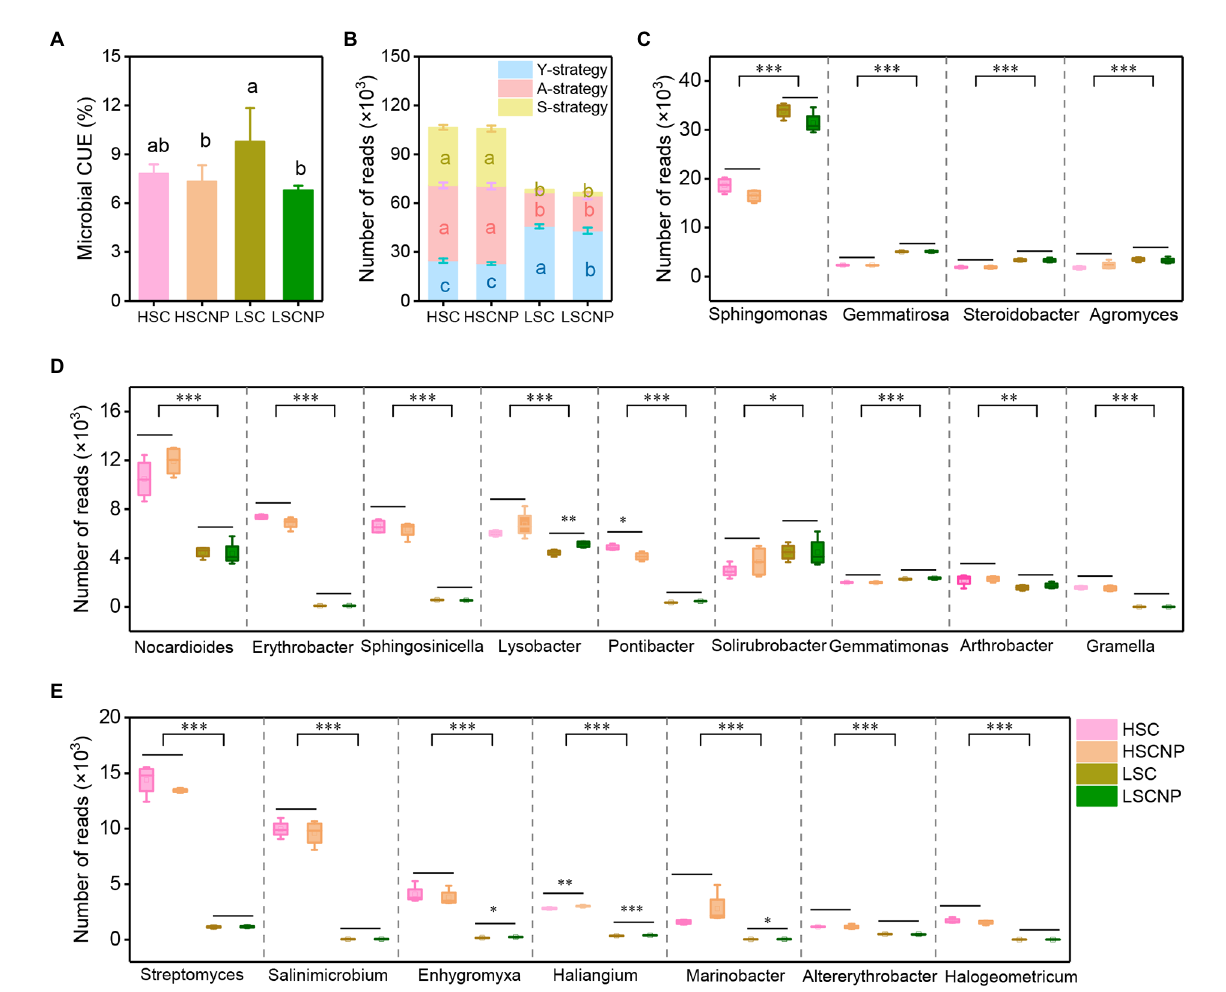
FIGURE 2 Soil microbial carbon use efficiency (CUE) after 7 days of incubation (A) . The sum of normalized read numbers of the top 20 abundant genera involved in the growth yield (Y-strategy), resource acquisition (A-strategy), and stress tolerance (S-strategy) (B) . The reads numbers of specific genes that were assigned to the Y-strategy (C) , A-strategy (D) , S-strategy (E) . Different letters indicate significant differences ( p < 0.05), * p < 0.05, ** p < 0.01. *** p < 0.001. HSC, high-salinity soil added with 13 C-glucose; HSCNP, high-salinity soil added with 13 C-glucose and NP nutrients; LSC, low-salinity soil added with 13 C-glucose; LSCNP, low-salinity soil added with 13 C-glucose and NP